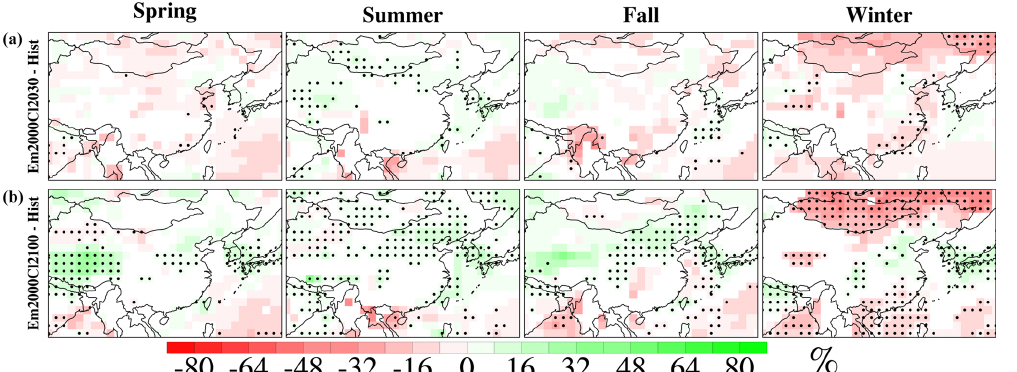
Figure 4. Spatial distribution of mean seasonal dry NO y deposition change over East Asia under experimental scenarios of ACCMIP (Em2000Cl2030 and Em2000Cl2100) relative to the historical period (2001–2010). The distribution of mean seasonal dry NO y deposition under the historical period is shown in Fig. 2a. Only grids with multi-model agreement are shown (grids without model agreement are in white), and among the grids with model agreement, stippling marks statistical significance ( α = 0 .